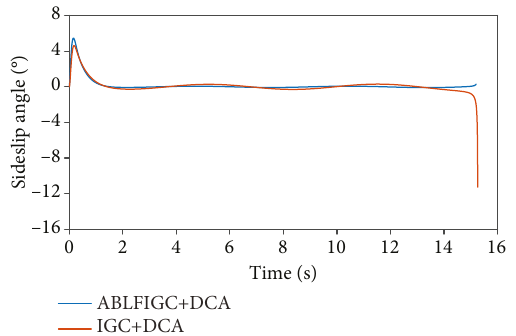
Figure 7: Yaw angular velocity curves of the interceptor missile in Scenario 1: ABLFIGC+DCA refers to a combination of the proposed asymmetric barrier Lyapunov function-based IGC algorithm and the dynamic control allocation algorithm; IGC+ DCA refers to a combination of the IGC algorithm subject to the traditional dynamic surface sliding-mode control law and the dynamic control allocation algorithm.